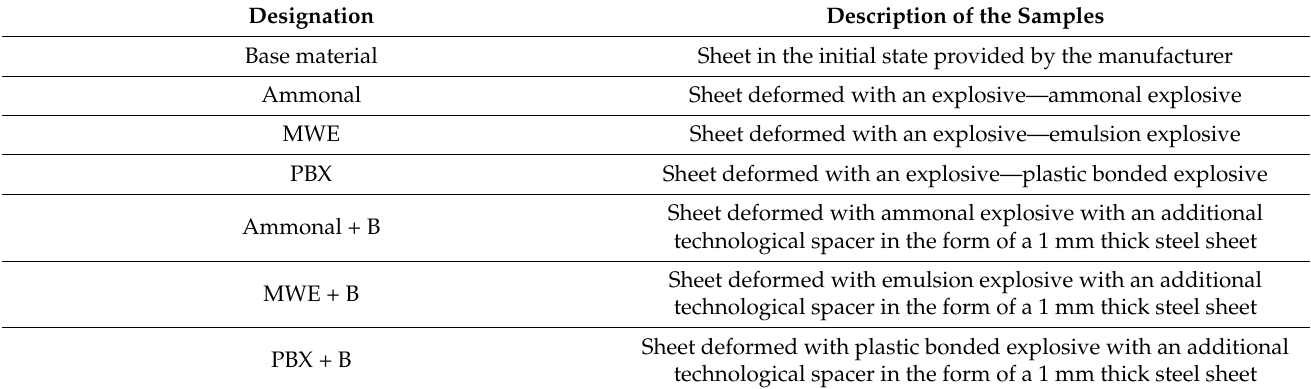
Table 1. Characteristics of the tested